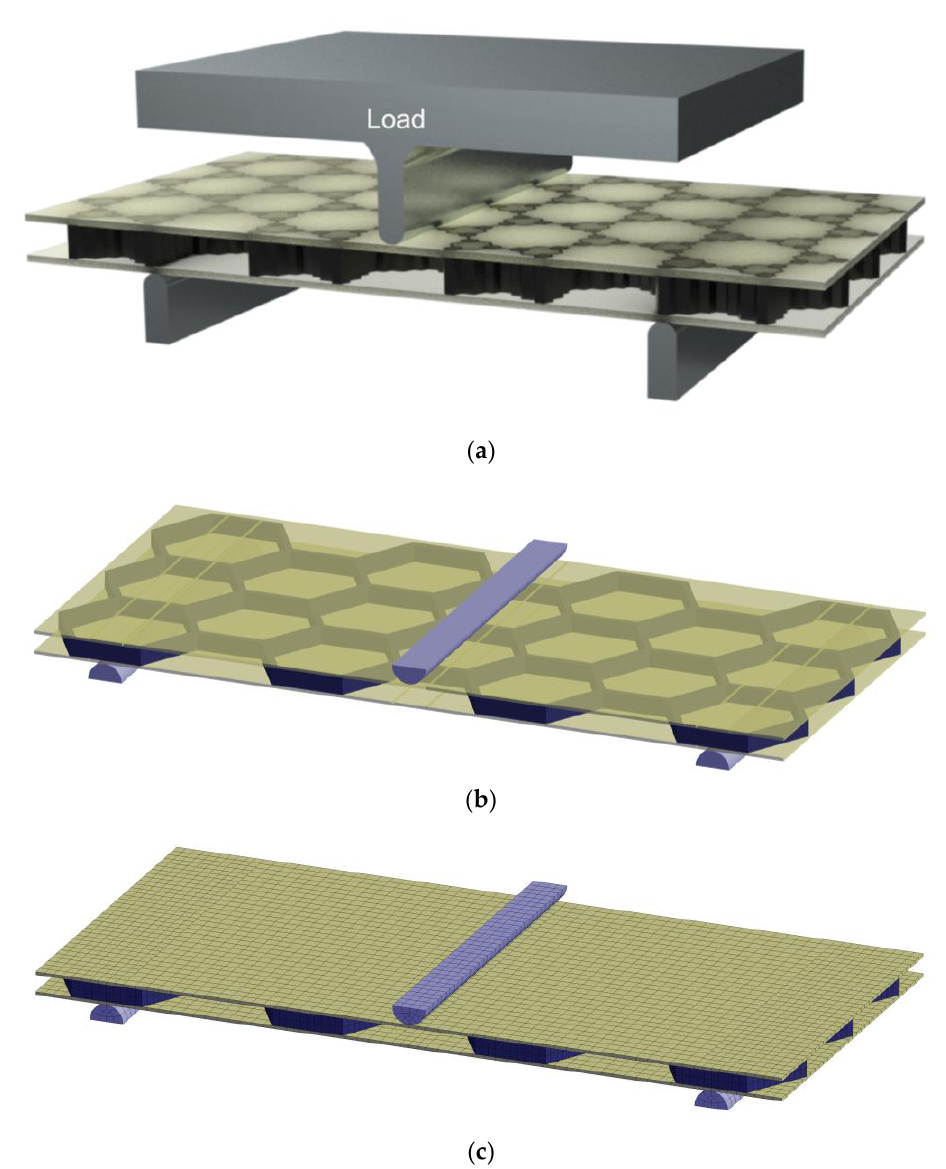
Figure 3. ( a ) A 3-point bending test set-up illustrated photorealistically with 2nd order hierarchy 3D-printed core assembled between the starch and fiberglass top and bottom skins, ( b ) CAD geometry of PLA honeycomb structure illustrated with zero level of hierarchy (regular honeycomb), ( c ) the corresponding mesh used in finite element